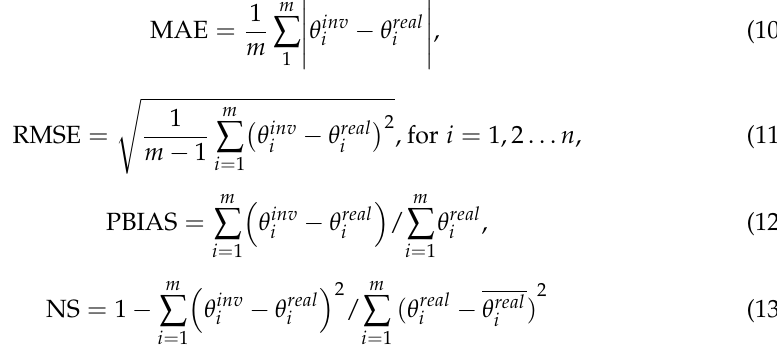
0 is the irrigation